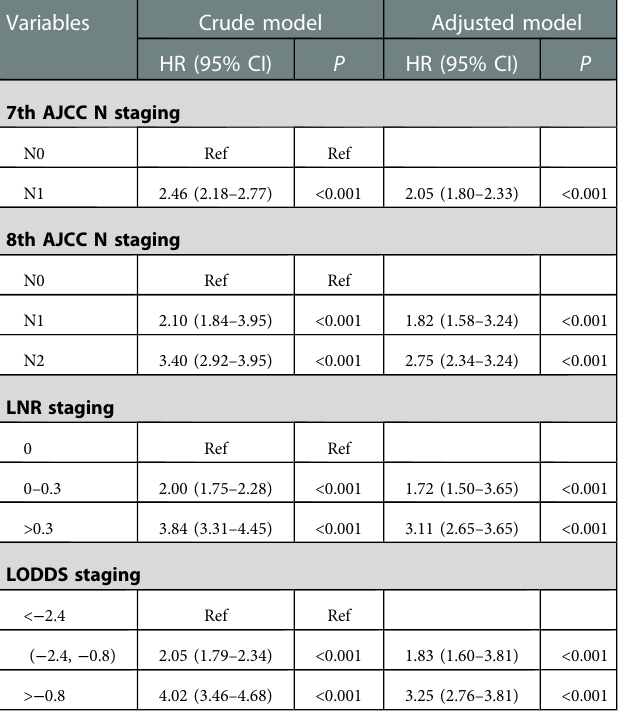
patients between training set and testing set was shown in Table 3 .